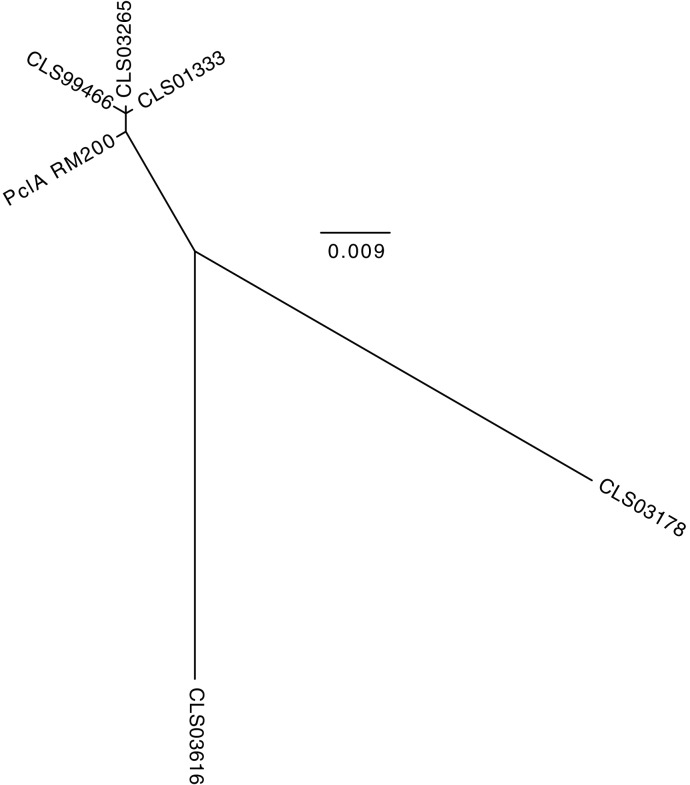
Maximum likelihood phylogenetic analysis of the S.pneumoniae RM200 PclA sequence and the orthologous proteins on the proteome array. The tree shows that the RM200 protein is most similar to CLS01333 and CLS03265, as well as the truncated non-functional variant CLS99466. The CLS03616 and CLS03178 variants are highly diverged from the variant expressed by RM200.